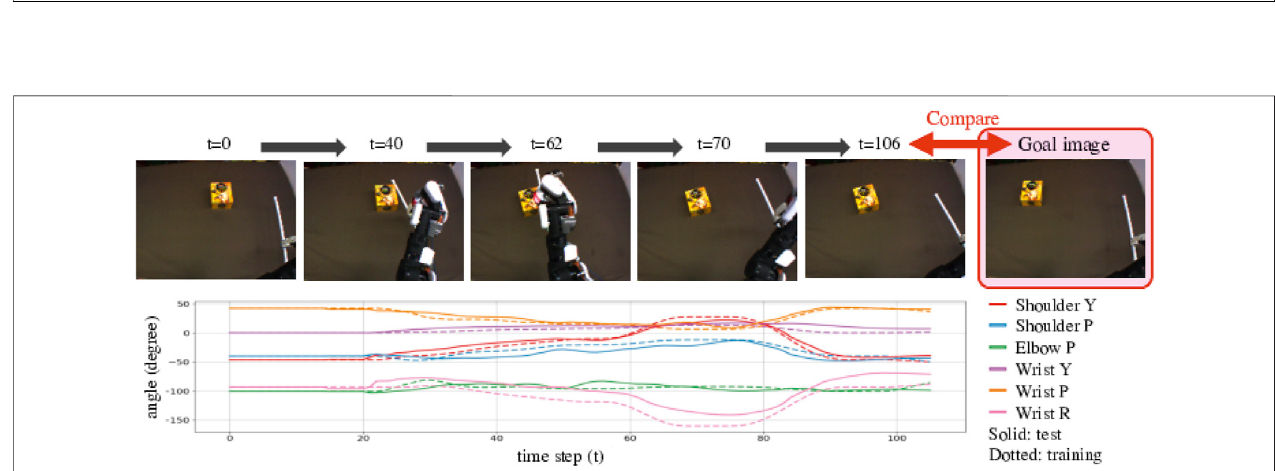
FIGURE 6 | Example result of Accuracy Evaluation using unknown objects and tools shown in the middle of Figure 2 . These pictures show camera images while the robot wasconducting thetask. We provided a goal image showingthe untrainedsmallyellow box, shiftedto theleft from the initial position. The robot then detected featuresofthe tool and the object and predicted asuitableaction, generating an action that would properly slide the box in a lowposition tomove itleft, reproducing the goal situation.Thebottomgraphshowsthegeneratedangletrajectorieswithsolidlines.Wecompare thelinestotrained angletrajectoriesforshiftingthesmallbox shown in the upper of Figure 2 to the left with dotted lines. The trajectory lines are almost same but sometimes shifted. We can say that the robot could detect proper action type and adjust it depending on the real time situation.